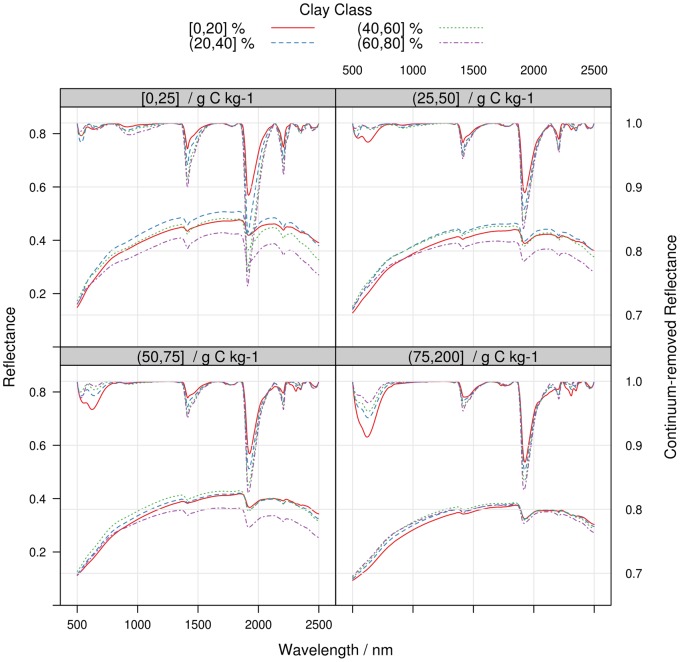
Mean reflectance (left scale) and continuum-removed reflectance (right scale) spectra of LUCAS mineral soil samples, computed for arbitrary clay and SOC classes.The clay classes are 0–20%, 20–40%, 40–60%, 60–80% and the SOC classes are 0–25 g C kg−1, 25–50 g C kg−1, 50–75 g C kg−1, 75–200 g C kg−1. Each panel regroups samples of a given SOC interval.